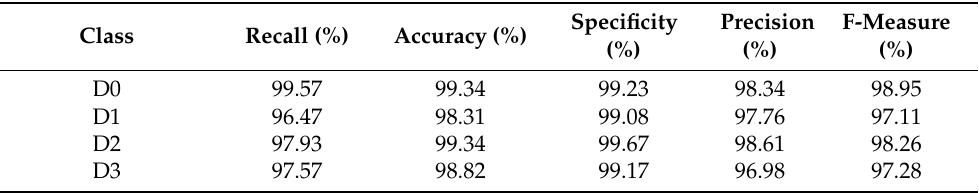
Table 7. Evaluation of the performance of the ANN-ICA classifier using the criteria derived from the confusion matrix, for the best training case.